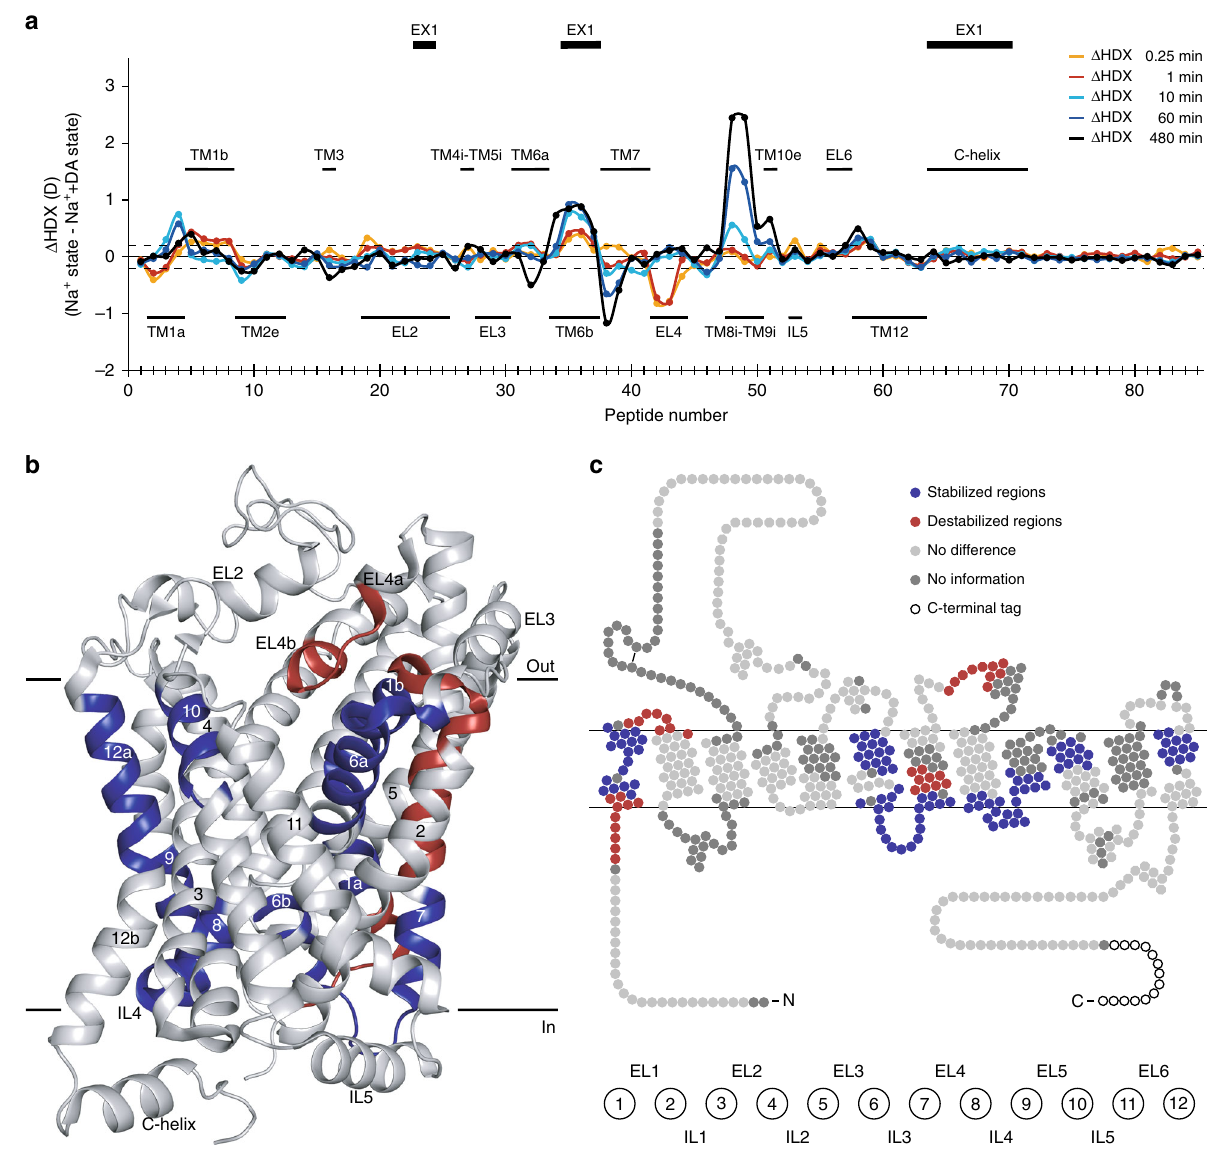
Fig. 4 Effect on local HDX upon dopamine binding to dDAT. a Chart showing differences in the average deuterium uptake ( Δ HDX) between the Na + - bound state and the Na + - and DA-bound state for the 85 identi fi ed peptides at the fi ve sampled time points (orange — 0.25 min; red — 1 min; cyan — 10 min; blue — 1 h; black — 8 h). The individual dDAT peptides are arranged along the x -axis starting from the N-terminal and ending on the C-terminal. The peptide number refers to Supplementary Table 2. Positive and negative values indicate reduced and increased HDX, respectively, upon binding of DA. Values represent means of either three (Na + + DA state) or six (Na + state) independent measurements. Structural motifs in dDAT are marked along the x -axis together with regions showing correlated exchange kinetics (EX1) in at least one of the two states. The dotted lines (±0.20 D) mark a threshold value for signi fi cant differences in HDX corresponding to the 95% con fi dence interval, calculated from the pooled standard deviations for all time points. b , c Regions showing signi fi cant differences (Student ’ s t -test p -value < 0.01) in deuterium uptake between the Na + -bound state and the Na + - and DA-bound state for at least two consecutive time points are mapped onto the crystal structure ( b ) (PDB ID: 4XP1) and snake diagram ( c ) of dDAT. Regions are colored red and blue to indicate dDAT segments becoming destabilized (increased HDX) or stabilized (decreased HDX), respectively, upon binding of DA. Regions colored light gray displayed unchanged HDX while regions in dark gray were uncovered by peptide sequences. Wild-type dDAT regions including part of EL2 (residue 162 – 202) and the N- and C-termini (residue 1 – 24 and 601 – 645, respectively) are only marked on the snake diagram in c as they were not resolved in the crystal structure ( b ) or were truncated in the construct used for crystallization. Source data are provided as a Source Data fi (Table 1). Importantly, the difference between the high- and low- cooperative fl uctuation of more than one helical turn, while the mass populations allowed us to estimate the number of amides difference seen for the TM6b-IL3-TM7 region corresponds to the participating in the fl uctuation events (Table 1). These numbers exchange of 6 – 7 backbone amide hydrogens or involvement of reveal cooperative fl uctuation of helical stretches spanning several 1.7 – 1.9 helical turns. The cooperative fl uctuations in helical residues. For peptide 215 – 222 covering the helical regions of EL2, structures in dDAT reveal relatively slow local motion events. the difference between the two populations corresponds to Notably, we did not sample longer time intervals than 480 min as exchange of 4 – 5 backbone amide hydrogens, which re fl ects we have evidence that the stability of the dDAT apo state at 25 °C